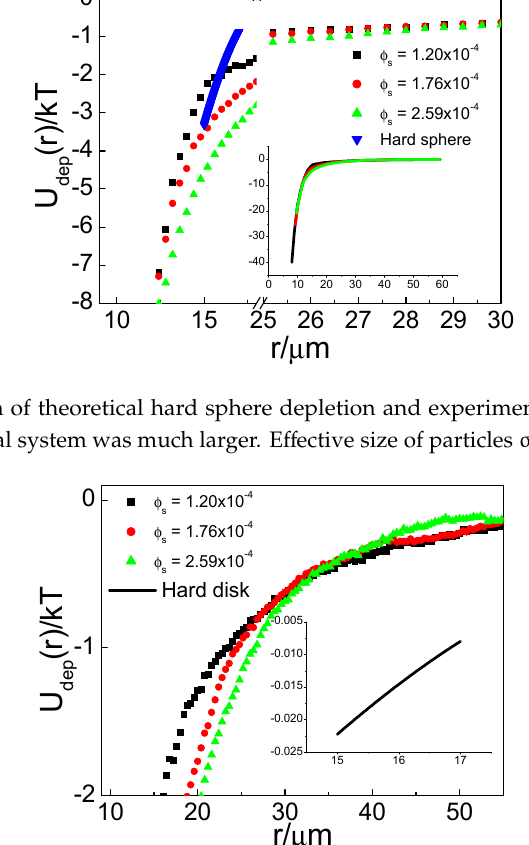
Figure 9. Comparison of theoretical hard disk depletion and experimental results: attraction in experimental interfacial system was much larger. Effective size of disk σ L = 15 µm, σ s =2 µm. Although there has reported successful theoretical prediction for mapping between soft potential and hard potential in the ultra-dilute system [40], substantial divergence of experimentally measured results of soft interacting particles from hard particles were found in our results.